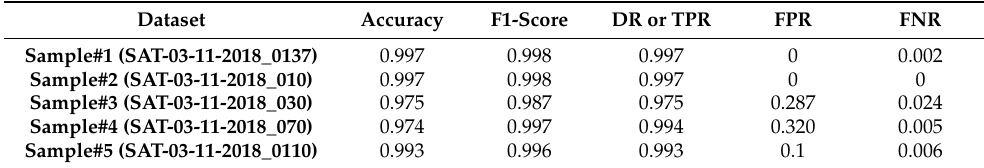
Table 4. The confusion matrix results for ESPRT, based on the CIC-DDoS2019 dataset. Dataset Accuracy